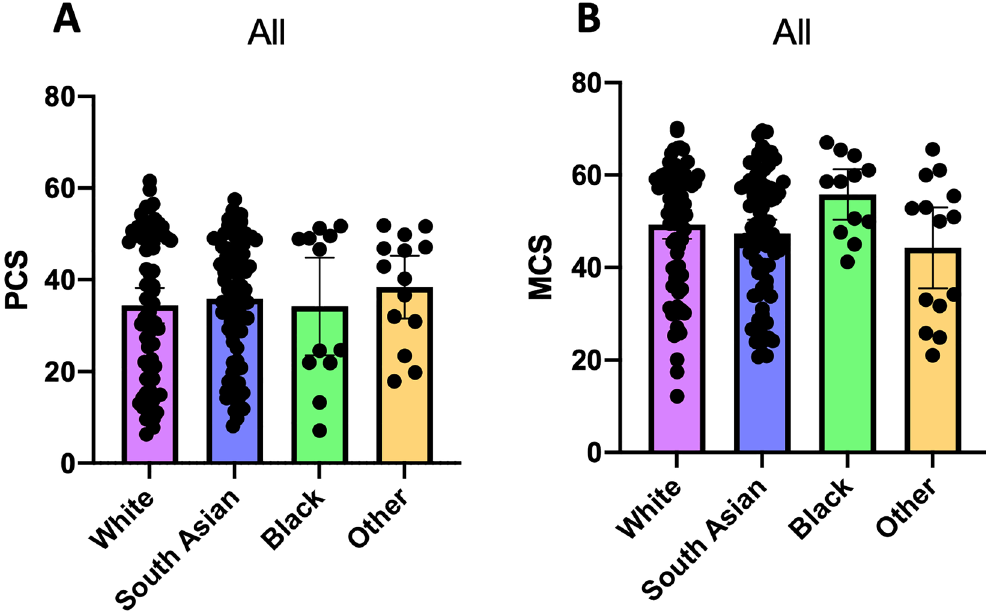
Figure 2. Physical and Mental Component Scores stratified by ethnicity. PCS physical component summary, MCS mental component summary. ( A ) All NAFLD PCS stratified by ethnicity; ( B ) All NAFLD MCS stratified by ethnicity.